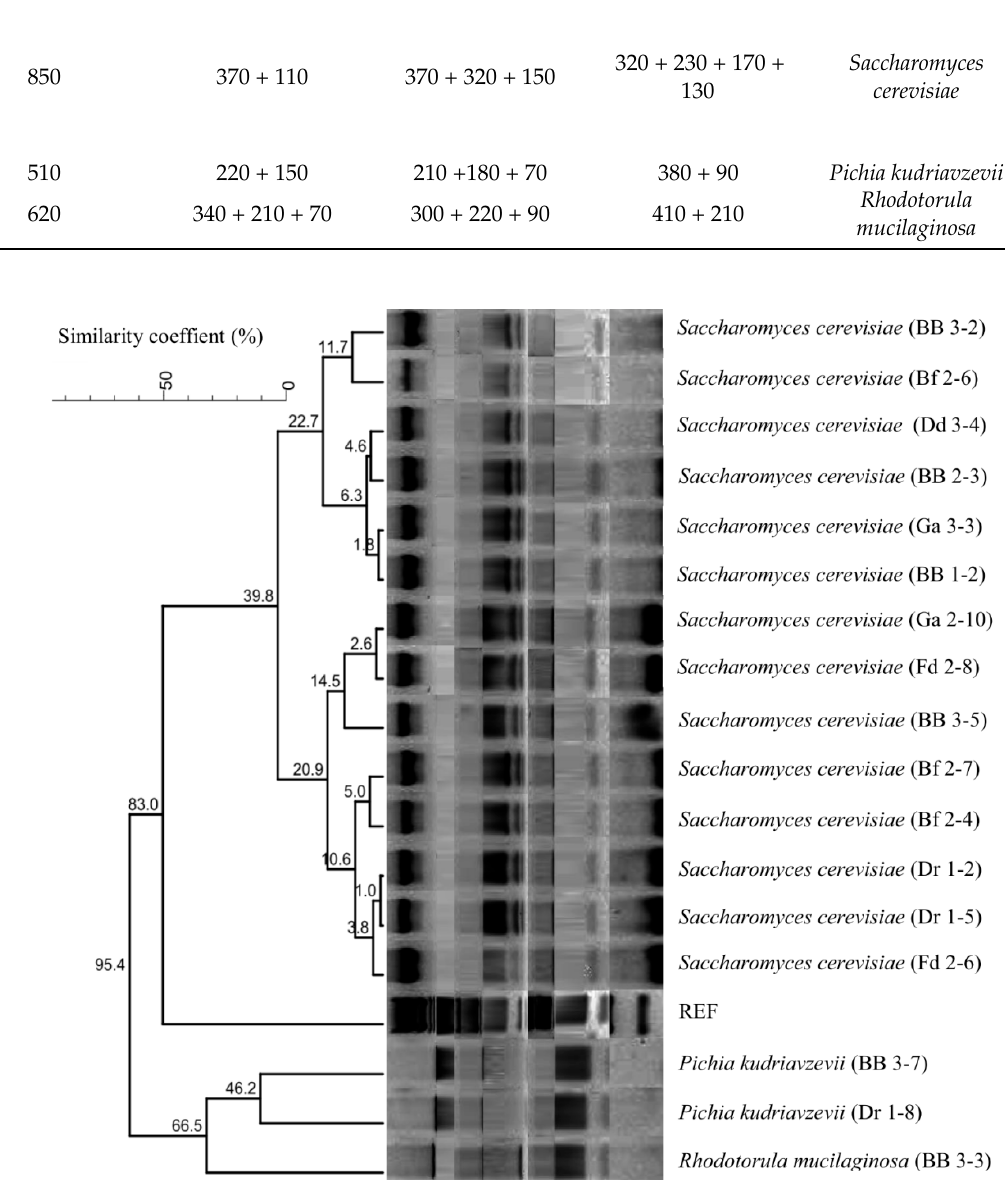
Figure 1. Dendrogram produced by comparing the RFLP-PCR profiles of yeast strains with the restriction enzymes Hinf I, Hha I, and Hae III with the PCR product profiles using Gel Compar Software, Applied Maths, Sint-Martens-Latem, Belgium, and clustering the data using the UPGMA method. The identifications at the species level obtained by ITS-RFLP analysis were confirmed by sequencing of the 5.8-ITS sequence of one yeast strain from each group and validated by high similarity percentages (from 99.35% to 100%) with respect to different ITS sequences available in the NCBI databases. In addition, the sequences stored in the NCBI database can be downloaded using the accession numbers OQ179952 ( S. cerevisiae Ga 2-10),